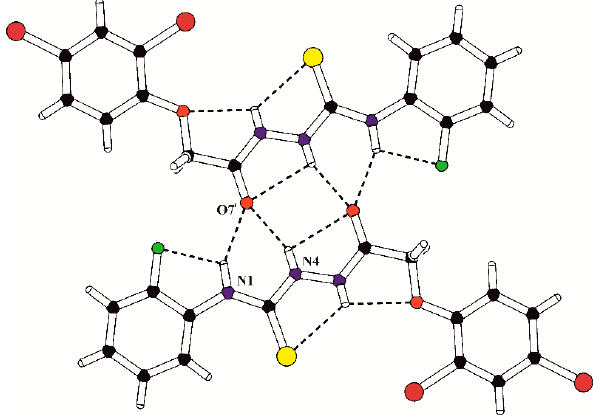
Figure 2. The structural motif (molecular dimer) formed by inversion-related molecules in the crystal of PK1. The intra- and intermolecular hydrogen bonds are marked with dashed lines; ( i ) = − x , 2 − y , − z